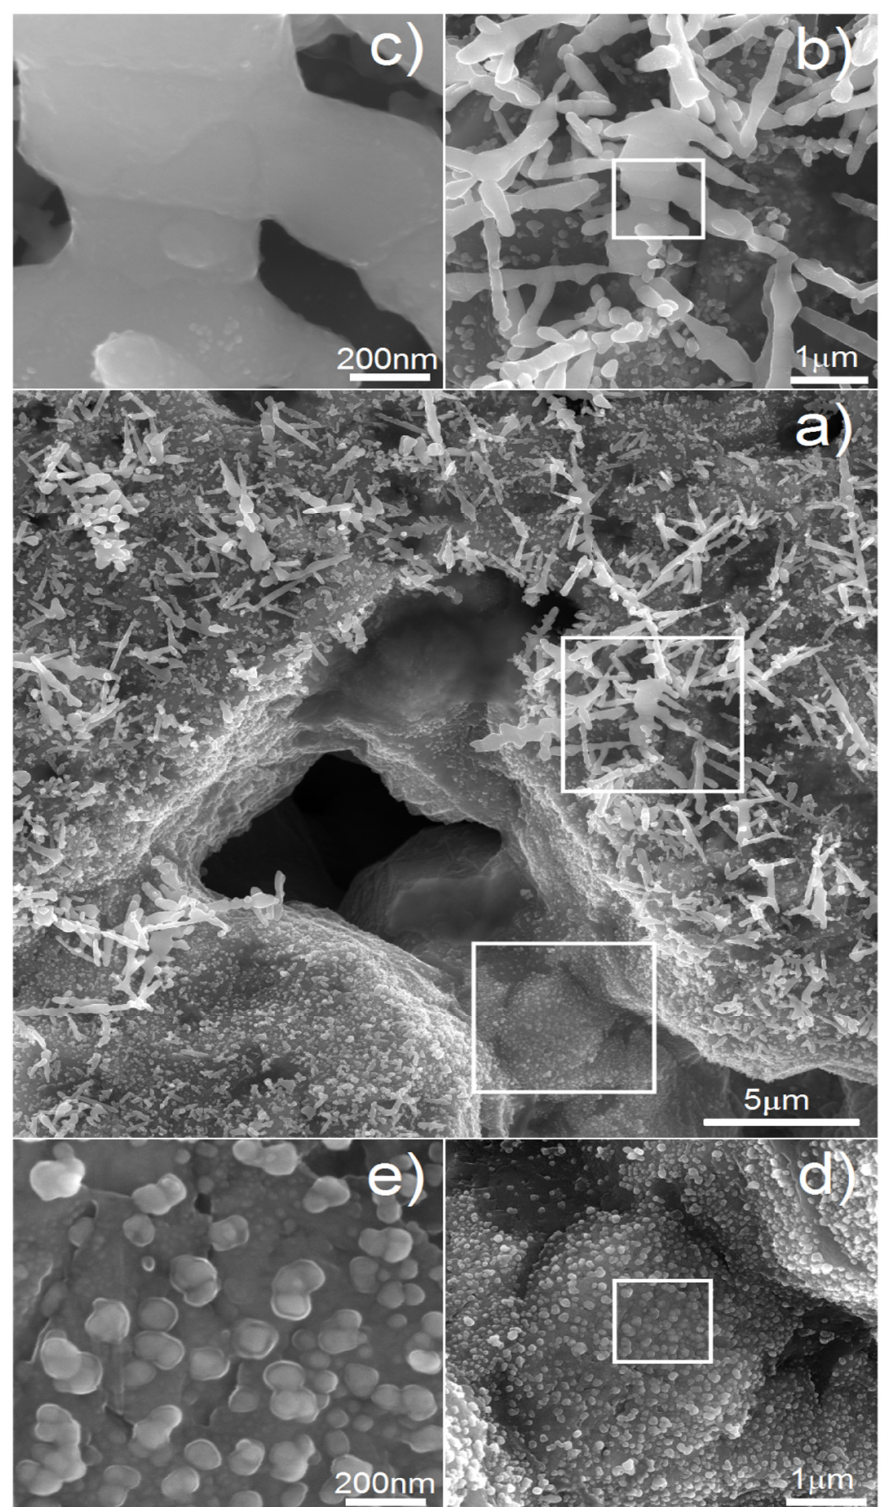
Figure 7. SEM micrographs of the Ti20Nb5Zr foam with electrochemically deposited Ag particles: ( a ) general view; ( b , c ) various magnifications of tree-like Ag structure; ( d , e ) various magnifications of Ag nanoparticles.